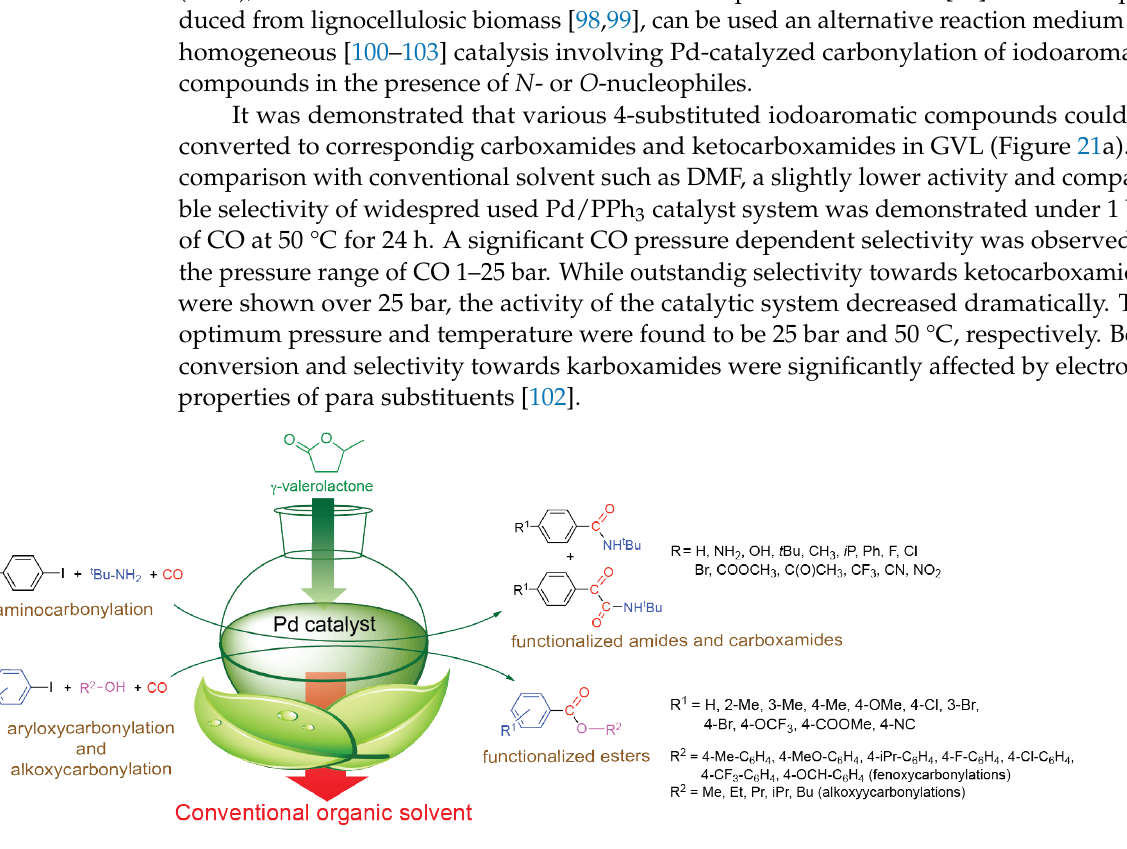
Figure 21. Conversion of iodoaromatic compounds in